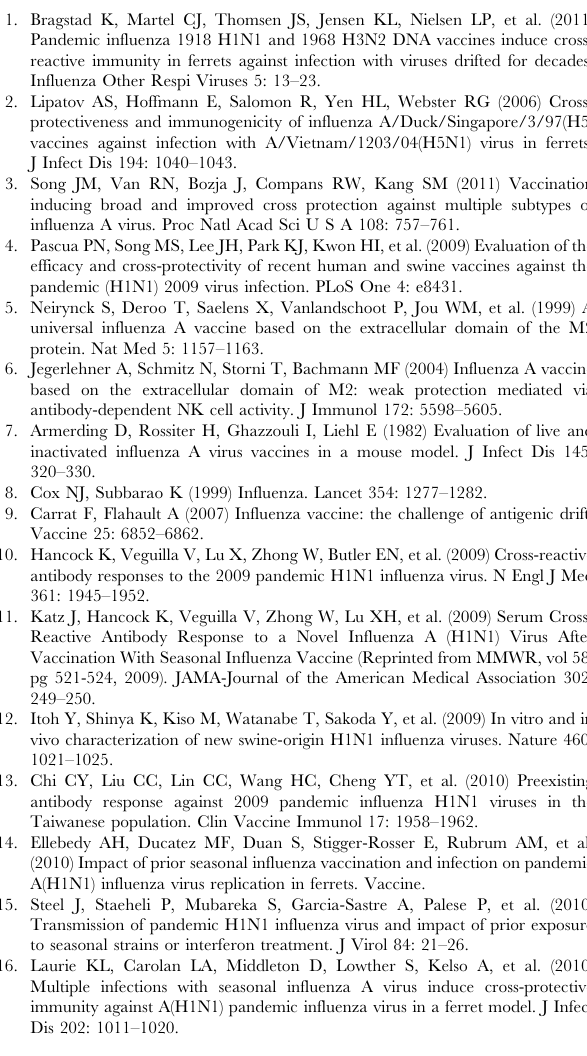
Figure S3 Analysis of anti N2 antibodies on protection against pandemic H1N1 2009 virus. Naı¨ve Balb/c mice were injected intraperitoneally with pooled sera collected from mice infected with 7 + 1 rg X 2 31 or inoculated with PBS. All